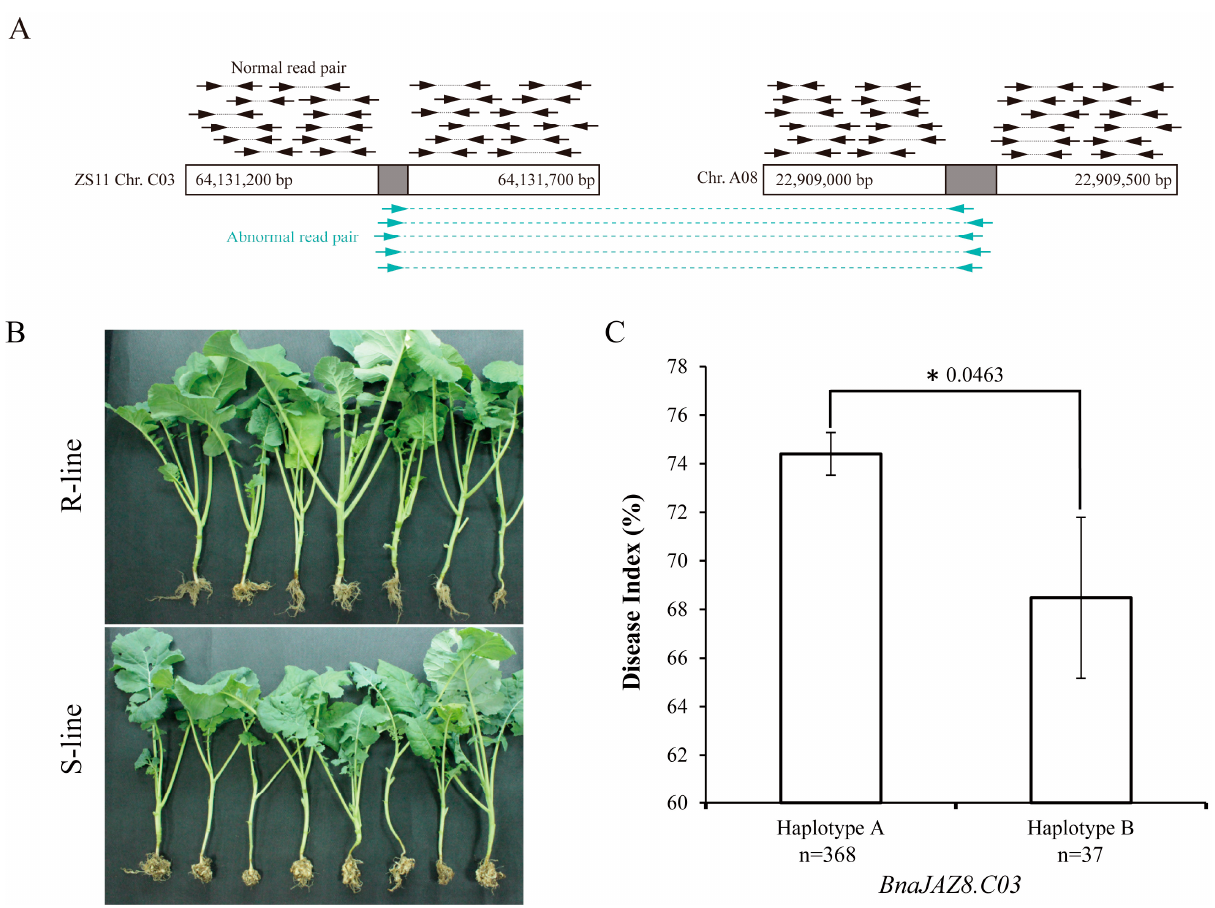
Figure 6. Structural variation and analysis of significance of the differences in resistance. The translo- cation was detected in BnaJAZ8.C03 , which resulted in the differences in resistance to P. brassicae . The black opposite arrows represent the normal read pairs. The green opposite arrows represent the abnormal read pairs, one end of which was located on the BnaC03 chromosome, but the other end was derived from BnaA08 ( A ). The performance of resistant (“28669”) and susceptible (“YJ-8”) accessions after 42 days infected by P. brassicae ( B ). The significance of resistance difference between accessions with and without the translocation in population. Haplotype A represented the average disease index of accessions without the translocation (including 368 accessions), and the haplotype B represented the average disease index of accessions with translocation (including 37 accessions). The p -value of the t -test is followed by the asterisk ( C